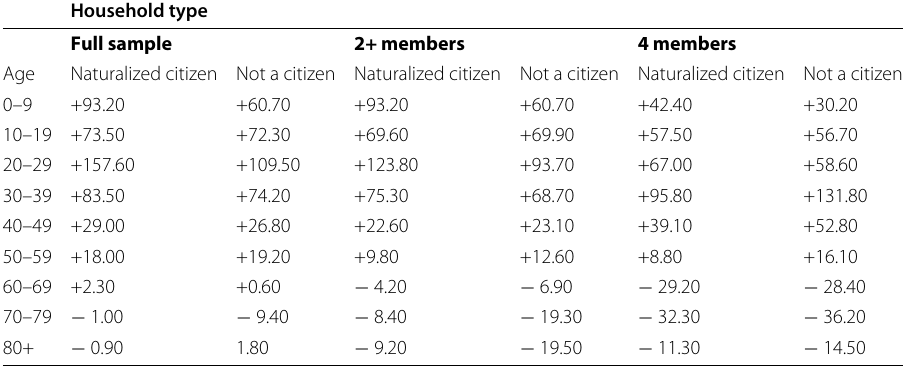
Table 14 Theoretical over/under-mortality ratio related to secondary infections (head-of-household citizenship